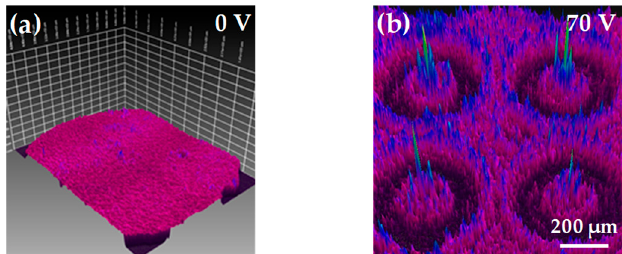
Figure 3. The 3D profiles of the beam intensity of the BPLC microlens array under the external voltage of ( a ) 0 V and ( b ) 70 V.